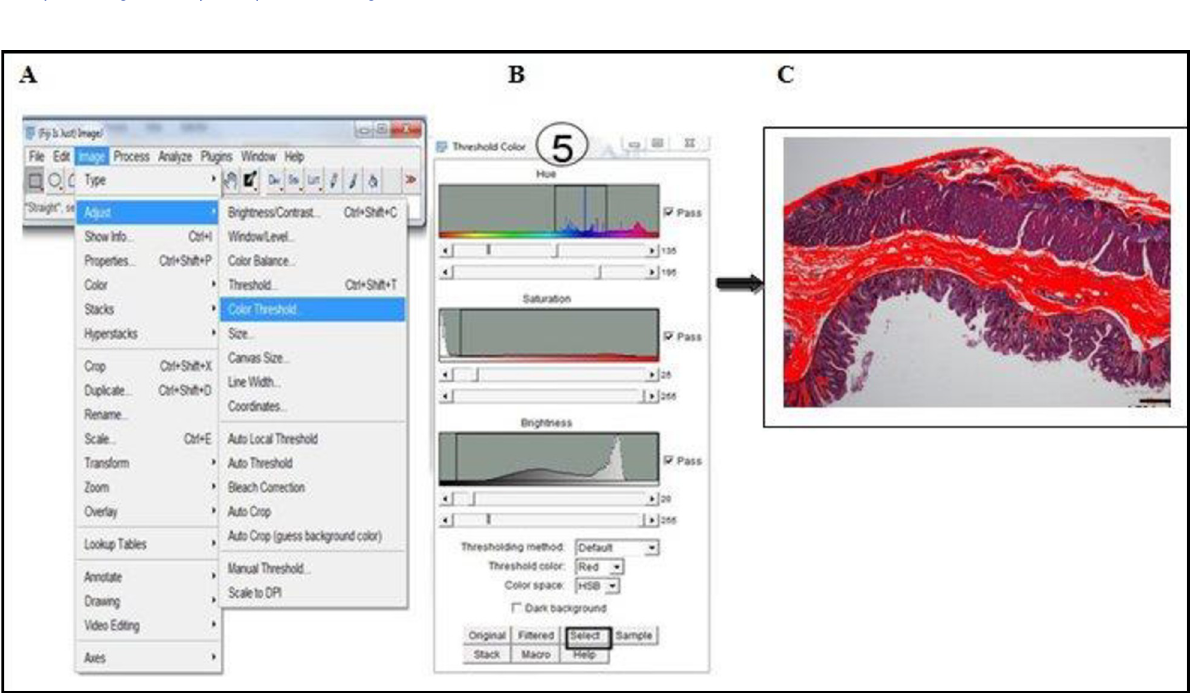
Fig 2. Deconvolution of colour images and identification of blue-stained collagen fibres via colour threshold. A) Under “Image” menu, then to “Adjust” and when “Colour Threshold” is selected, a dialogue box appears ( 5 ). ( B ) Manual threshold of Hue (135–195), Saturation (25–255) and Brightness (20–255) was set at these values and optimal blue colour intensity was achieved ( C ). Scale bars represent 60 μ m.